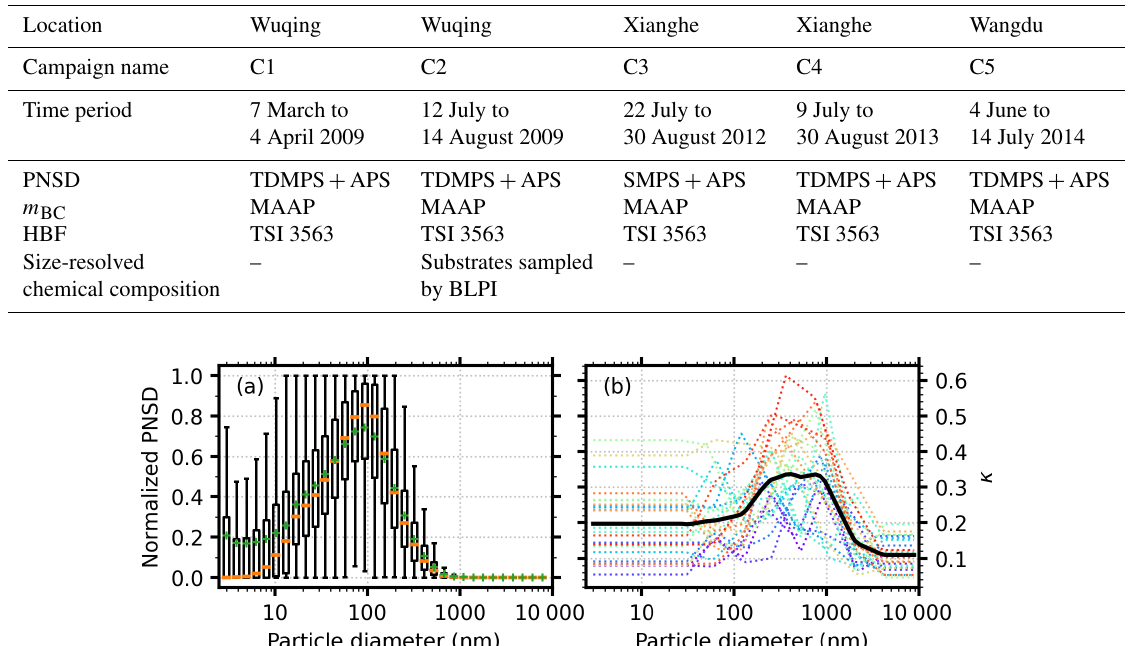
Table 1. Locations, time periods, parameters, and instruments of five field campaigns.